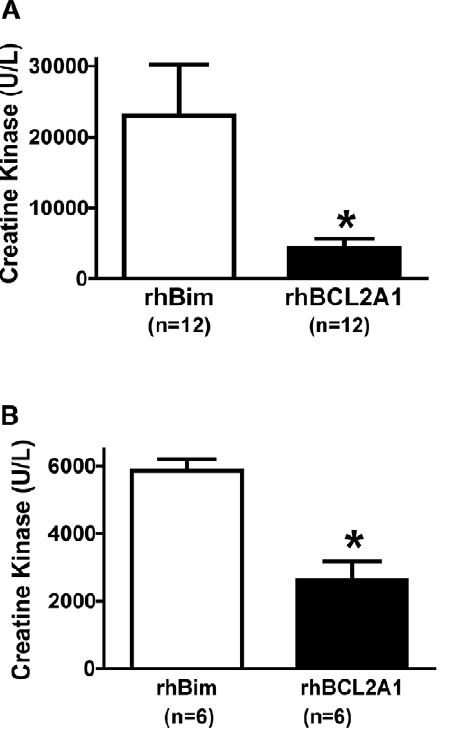
Figure 2. Pretreatment with rhBCL2A1 protects hind limb skeletal muscle from I/R injury. (A) Plasma CK levels were determined in mice pretreated with rhBCL2A1 protein (1 m g/mouse ip) or rhBim (1 m g/mouse ip) the day prior to hind limb I/R by aorta cross-clamping. Plasma CK levels were significantly decreased in the rhBCL2A1-pretreated mice (*p , 0.05). (B) Plasma CK levels were measured in rats pretreated with rhBCL2A1 protein (10 m g/rat ip) or rhBim (10 m g/rat ip) the day prior to hind limb I/R by tourniquet induced for 90 minutes of ischemia, followed by 3 hours of reperfusion. Plasma CK levels were significantly reduced in the rhBCL2A1-pretreated rats (*p , 0.05). doi:10.1371/journal.pone.0009103.g002 between the groups (Figure 5B). The infarct volume (V infarct ) relative to V LV in rhBCL2A1-treated mice was significantly less than in rhBim-treated mice. Infarct volume (V infarct ), expressed as